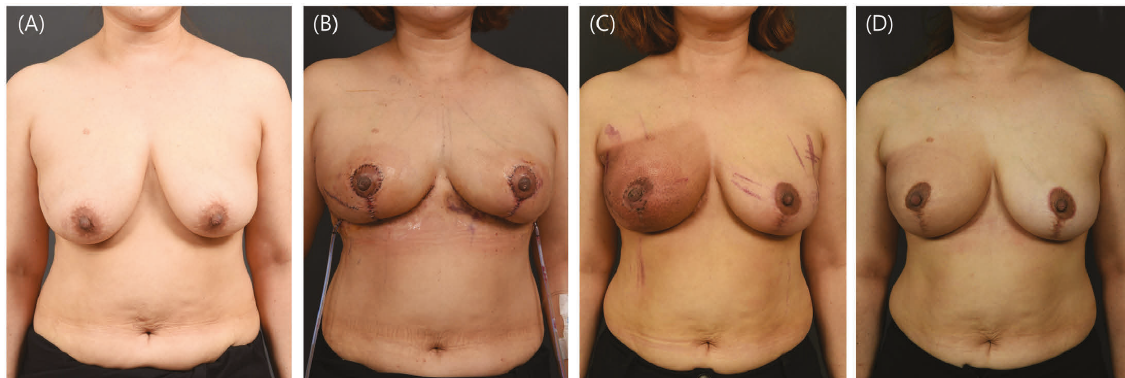
Figure 5: Partial mastectomy and reduction mammoplasty in a patient with right breast cancer. A patient with a breast cancer tumor in the right lower quadrant of the right breast, located far from the Wise pattern reduction mammoplasty design, underwent glandular reshaping and reduction mammoplasty followed by contralateral reduction mammoplasty for asymmetry. (a) Preoperative image. (b) Five days postoperative image. (c) Two months postoperative image. The patient had been undergoing adjuvant radiotherapy. The skin tanning was treated with moisturizer. (d) Fourteen months postoperative image. The tanning had healed and the patient reported satisfaction.